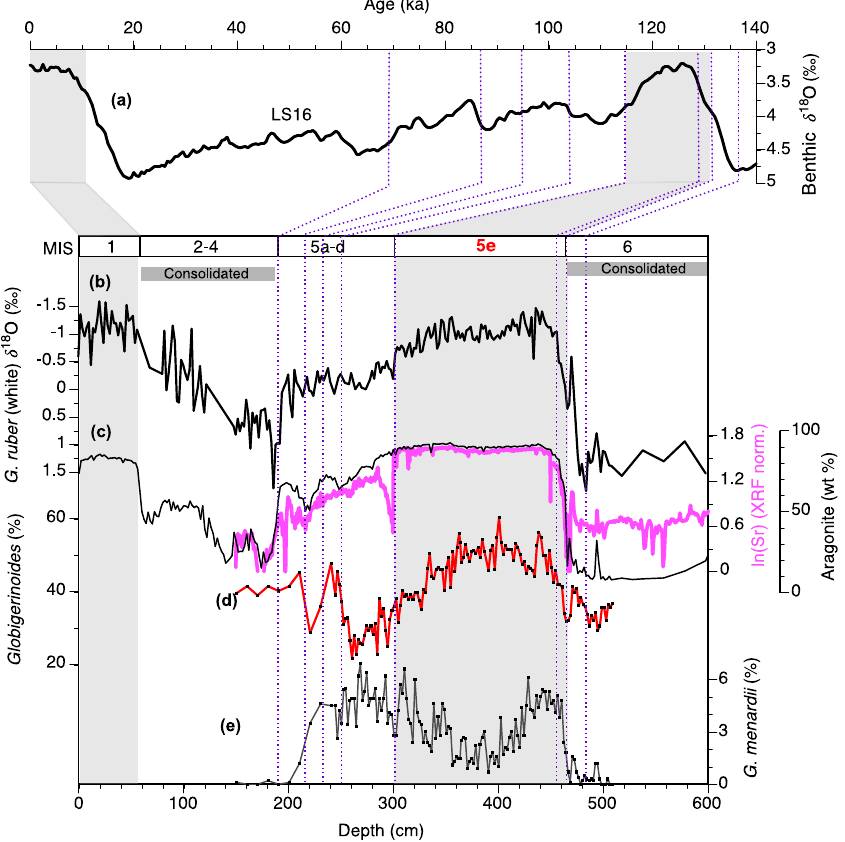
Figure 2. The age model for MIS 5 in core MD99-2202. The temporal framework is based on the alignment of (b) planktic δ 18 O values (Lantzsch et al., 2007) and (d) the relative abundance record of Globigerinoides species with (a) global benthic isotope stack LS16 (Lisiecki and Stern, 2016). (c) Aragonite content (in black; Lantzsch et al., 2007) and normalized elemental intensities of Sr (in magenta) as well as (e) relative abundances of G. menardii are shown to support the stratigraphic subdivision of MIS